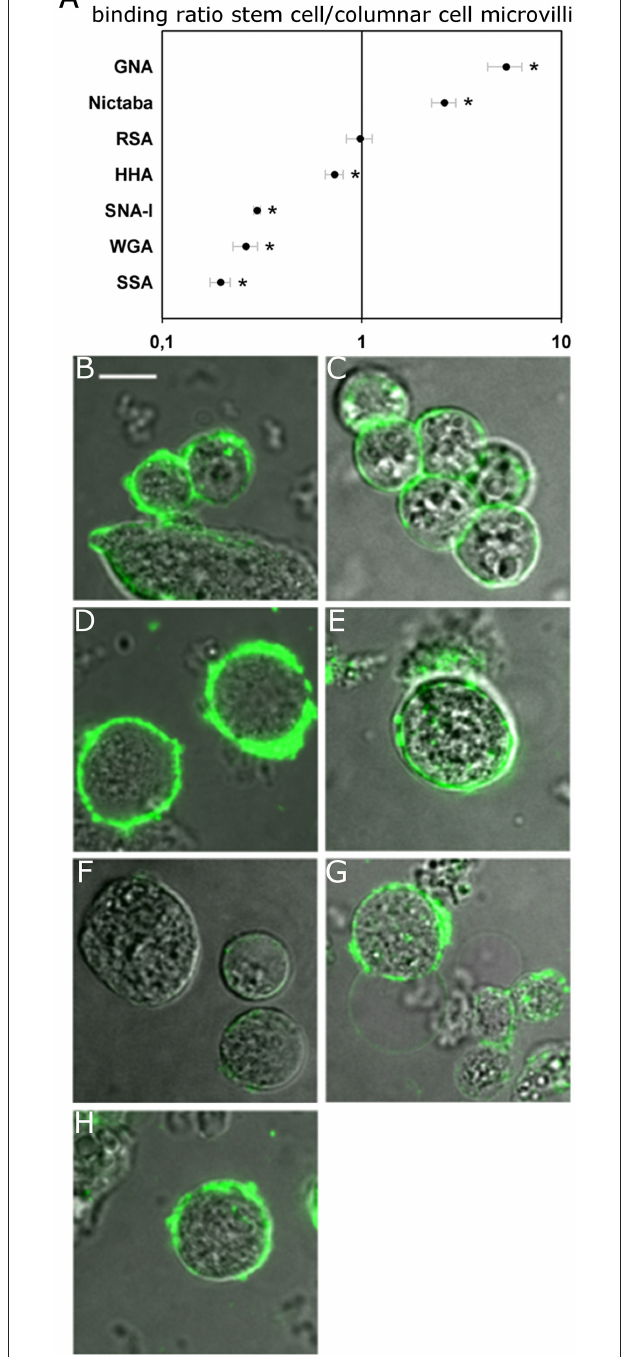
FIGURE 3 | Lectin binding to the surface of the midgut stem cells of Spodoptera littoralis . (A) Ratio of fluorescence intensity in cell membranes of the stem cells over the binding intensities to microvilli of columnar cells indicates differential lectin binding to the two types of cells. Data are presented as average values ± SEM. Asterisks indicate statistically significant differences ( p < 0.05, independent sample t -test). (B–H) Representative confocal images of stem cells incubated with FITC-labeled lectins: GNA (B) , Nictaba (C) , RSA (D) , HHA (E) , SNA-I (F) , WGA (G) , and SSA (H) . Scale bar is 10 µ